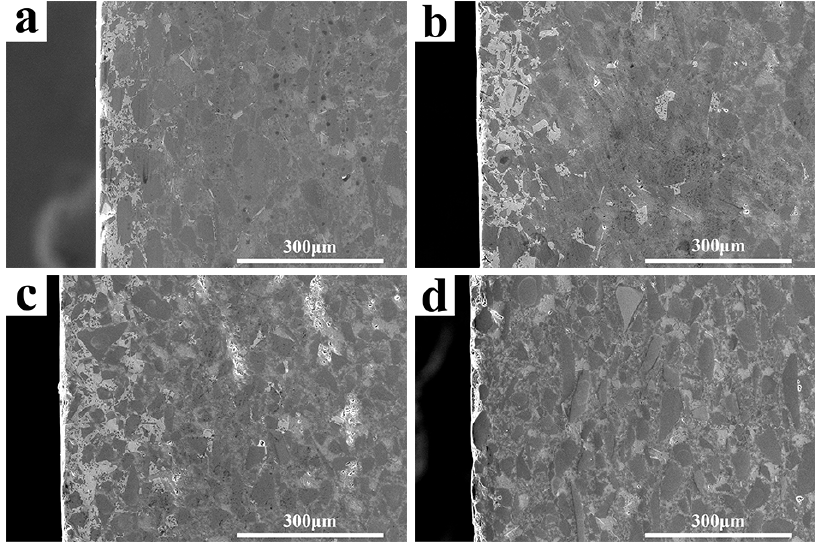
Figure 2. Microstructure of SiC ceramic infiltrated by Al alloy with different Si content: ( a ) 5 wt. %, ( b ) 10 wt. %, ( c ) 15 wt. %, and ( d ) 20 wt. %.